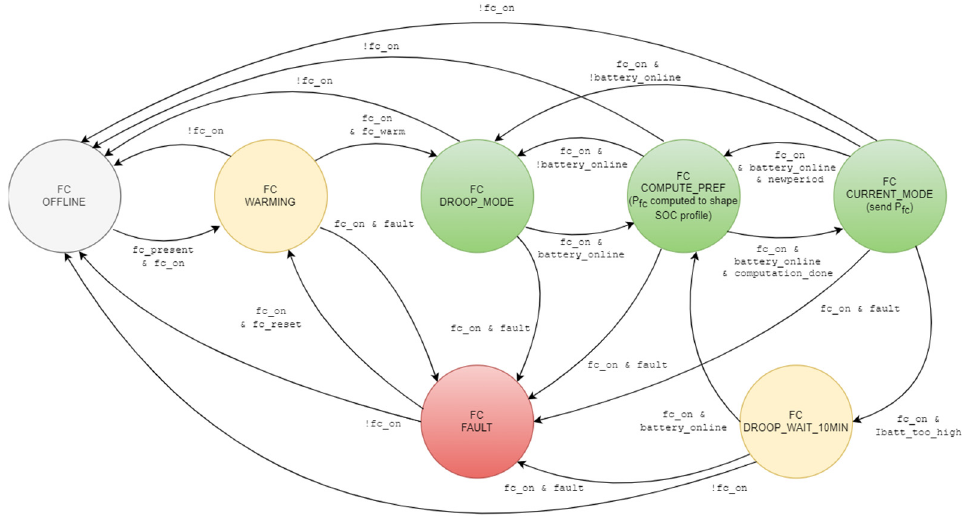
Figure 6. State diagram of the battery FSM.